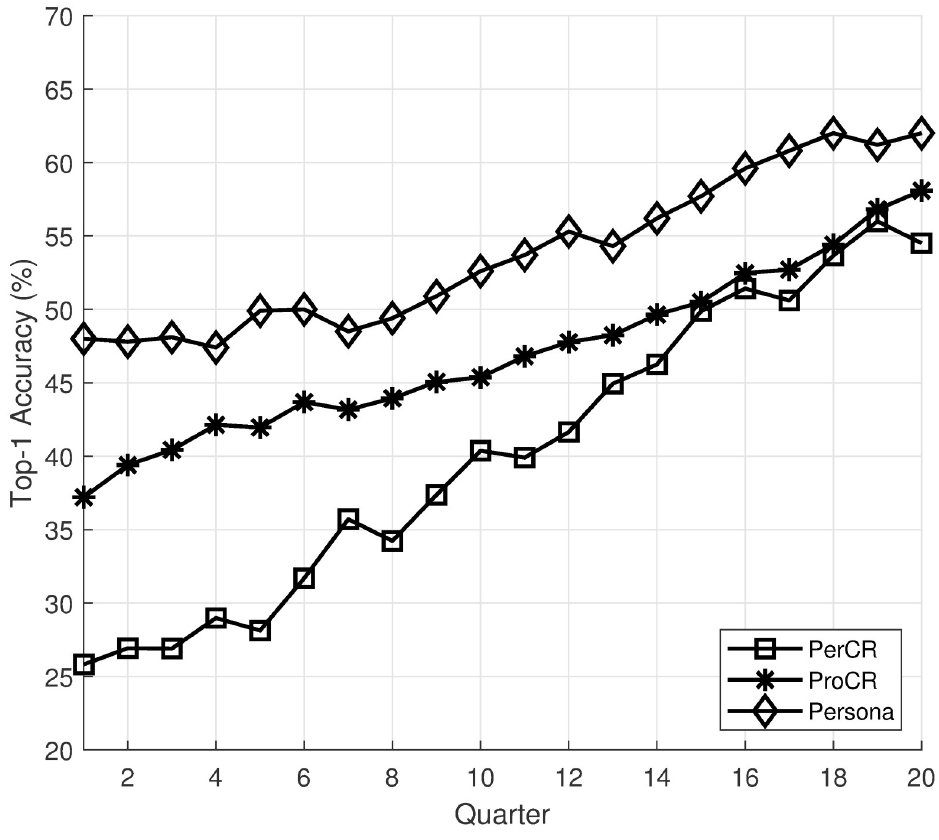
Fig 7. Top-1 accuracy over time of “Alexey